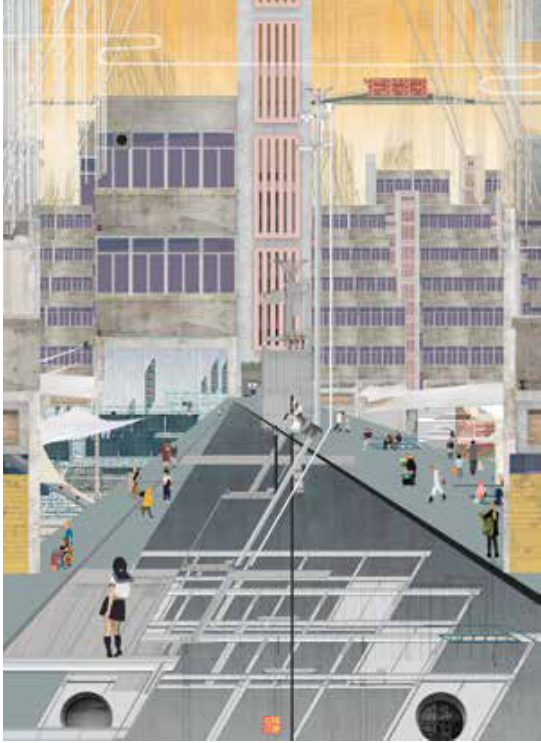
Figure 7: A girl gets lost on the crowded street. She finds a thing in between a narrow slit, something old and raw. Smells woody and display letters without screen and light, a book. Source: Olivia